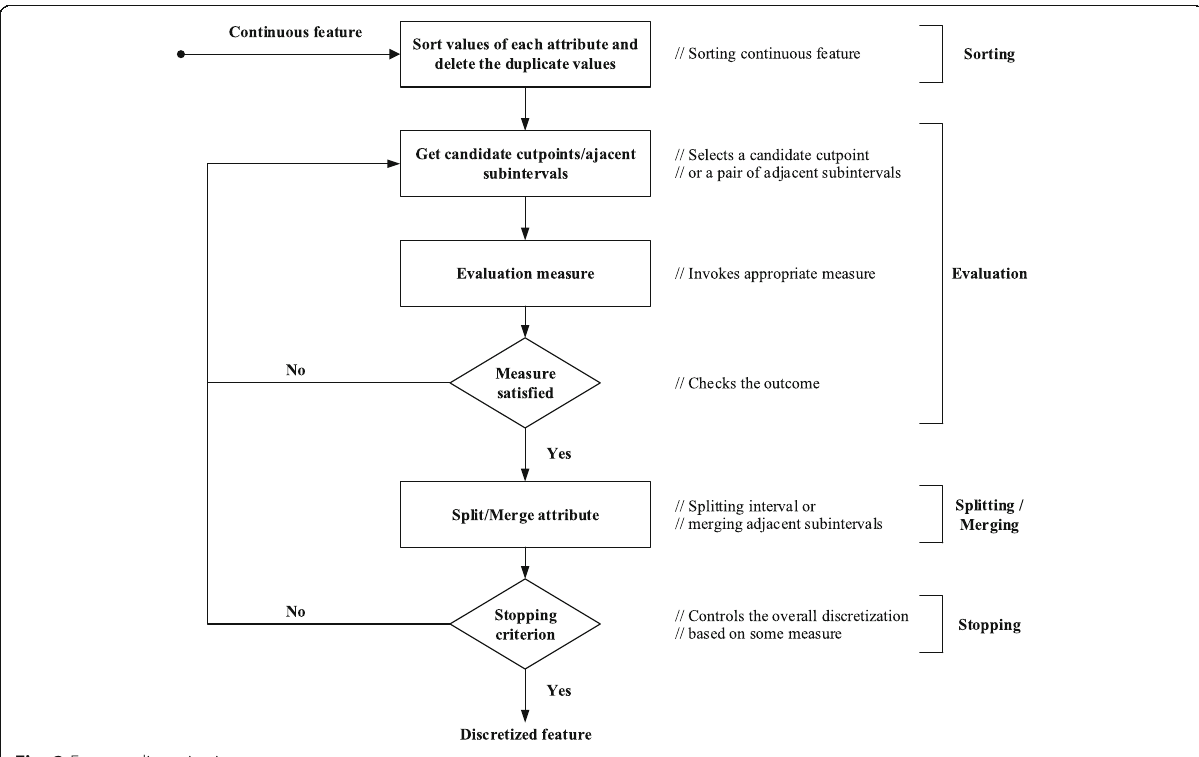
Fig. 2 Feature discretization